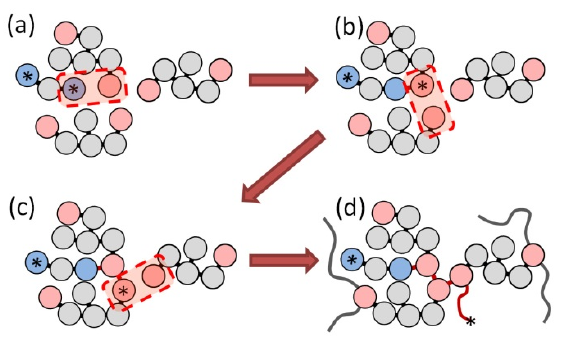
Figure 2. Schematic representation of coarse-grained reactions of initiation ( a , b ) and polymerization ( b – d ). Terminal beads of each monomer (red) and initiator (blue) have a nonzero valence; asterisk indicates an active bead. Red arrows show the reaction pathways.